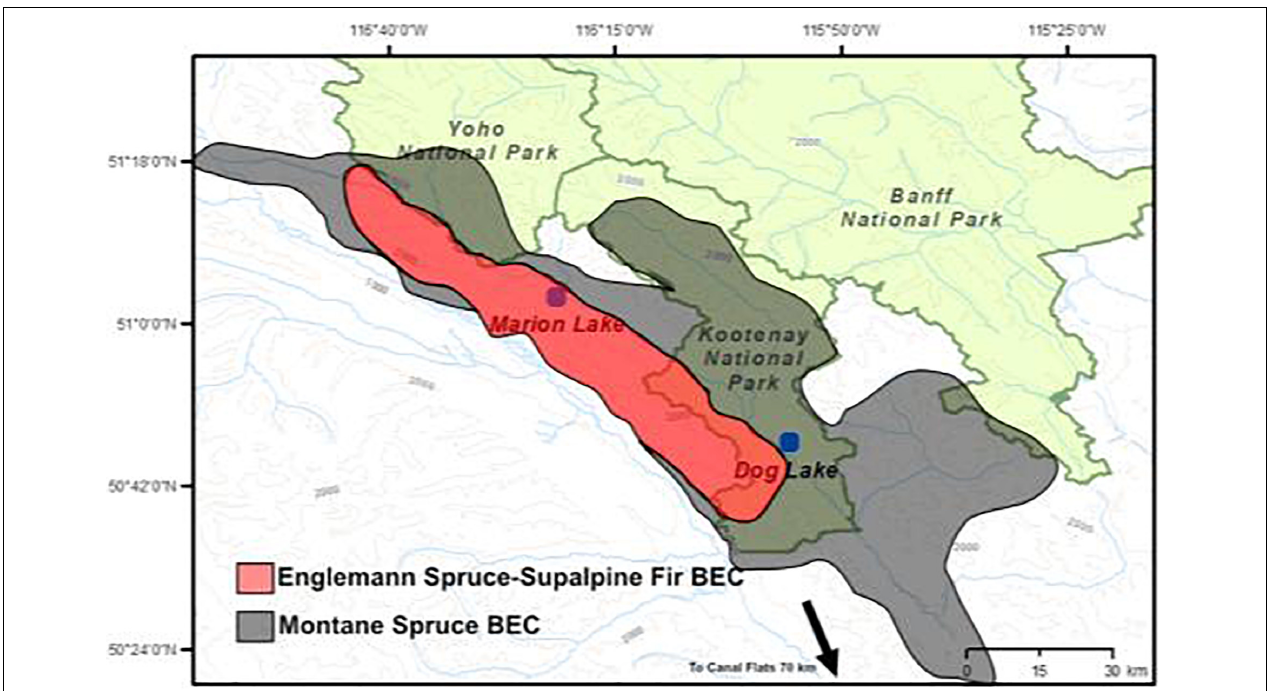
FIGURE 1 | Study area of Marion and Dog Lake. Shaded green areas represent National Parks. Blue lines represent waterways. BEC, Biogeoclimatic Zone.